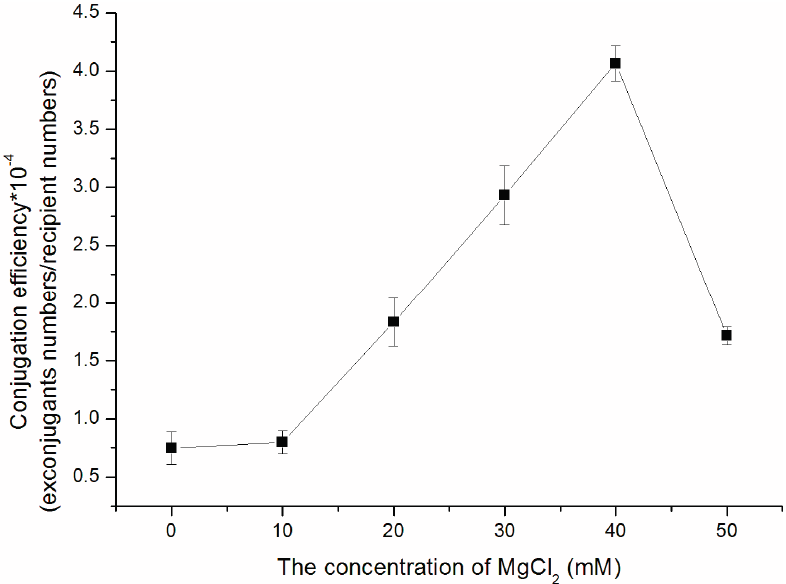
on conjugation efficiency with E. coli 2